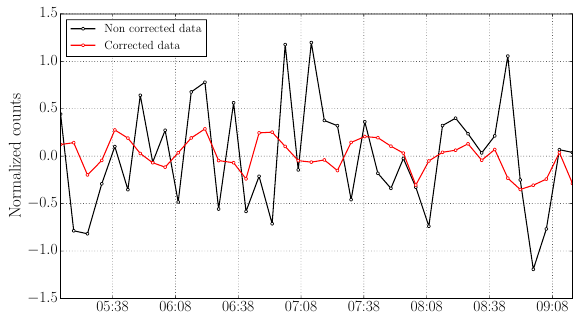
Figure 7. Average counts difference between measurements taken on ABB ( T ABB (cid:39) 25 ◦ C) and HBB ( T HBB = 55 ◦ C) through the fil- ter 7.9–9.5µm for 40 consecutive sequences. The black line was ob- tained without using the non-illuminated pixels, while the red line corresponds to corrected data. All data were translated to null aver- age for the sake of